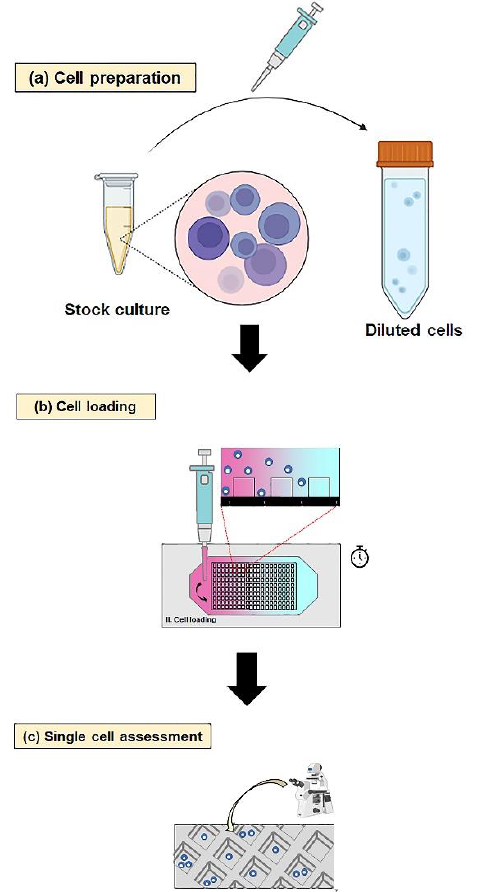
Figure 2. The process of operation for single-cell isolation using the MBM device. ( a ) Cell preparation of initial cell concentration by dilution method, ( b ) cell culture medium and cell loading into the MBM device, ( c ) single-cell assessment under an inverted microscope using 10× magnification.